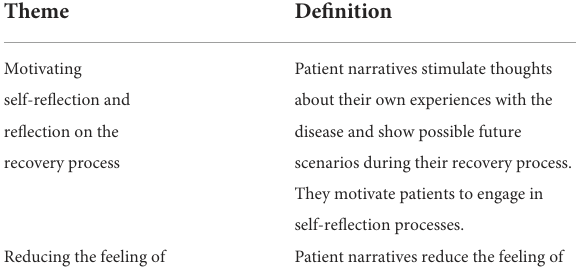
TABLE 1 Themes and